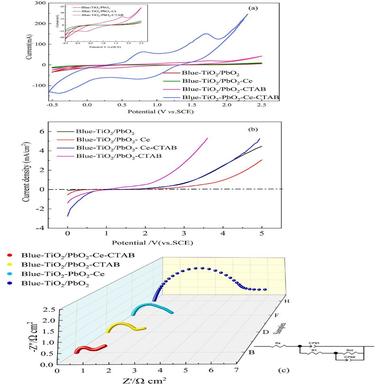
(a) CV curves of different electrodes; (b) LSV curves of different electrodes; (c) EIS spectra of different electrodes and fitted equivalent circuit;